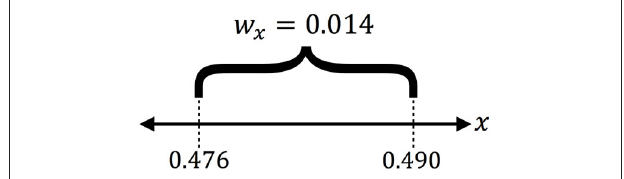
Frontiers in Materials |